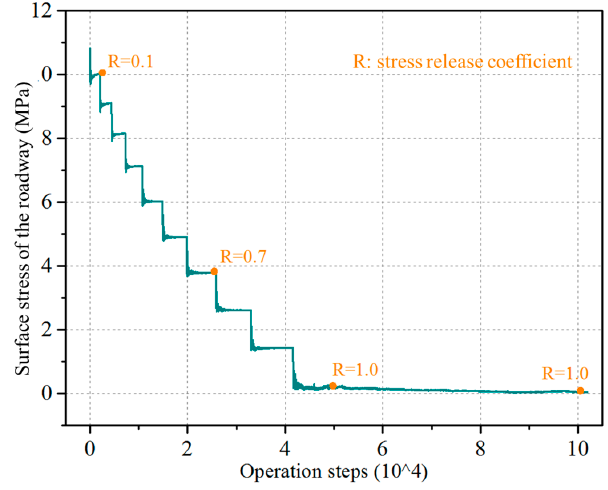
Figure 6. Surface stress evolution curve of the roadway.